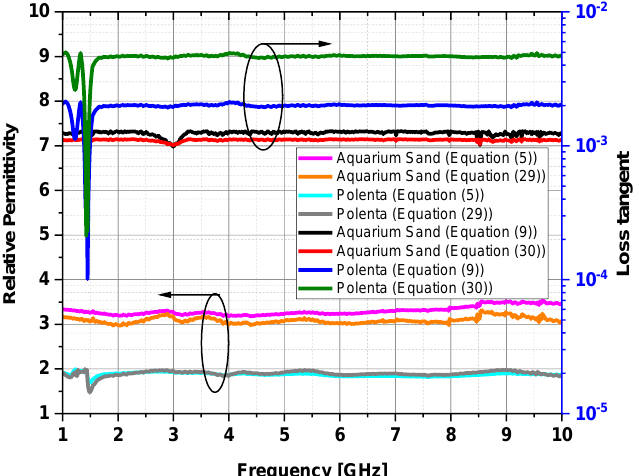
Figure 8. Relative permittivity and loss tangent of aquarium and polenta, extracted with the circular coaxial test cell.